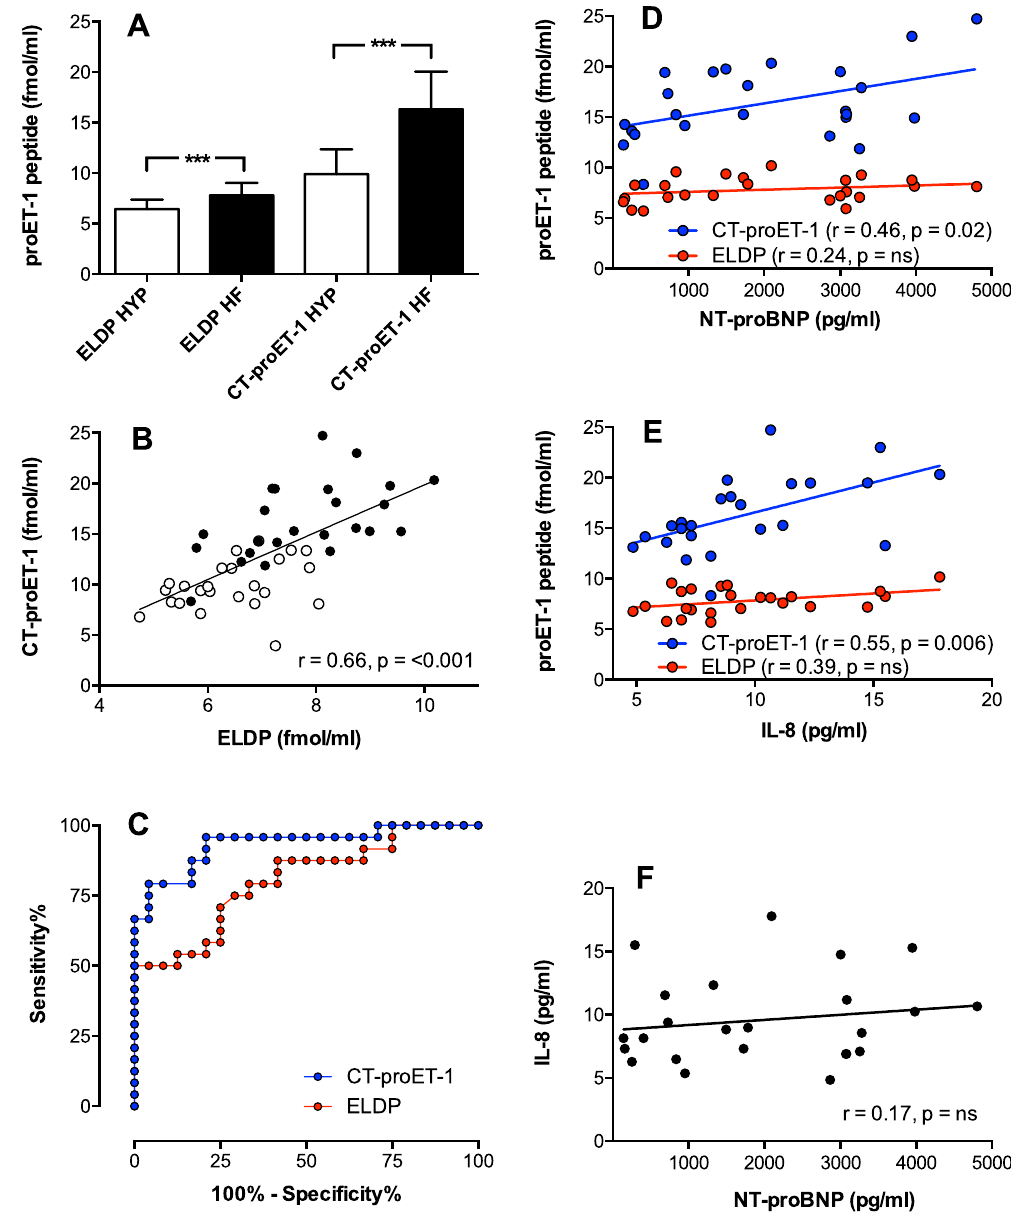
Figure 4. Comparison of plasma levels of ELDP and CT-proET-1 in hypertension and chronic heart failure. ( A ) Concentrations of ELDP and CT-proET-1 (mean ± SD) in each group (n = 24 per group) were compared by Student’s t-test, *** p < 0.001. ( B ) Correlation between individual plasma levels of ELDP and CT-proET-1 (open circles patients with hypertension, closed circles patients with chronic heart failure). ( C ) Comparison of ROC analyses for ELDP and CT-proET-1 detection of chronic heart failure. ( D ) and ( E ) Correlation between individual plasma levels of ELDP (red circles) and CT-proET-1 (blue circles) with NT-proBNP and IL-8 in patients with chronic heart failure. ( F ) Comparison of plasma levels of NT-proBNP and IL-8 in chronic heart